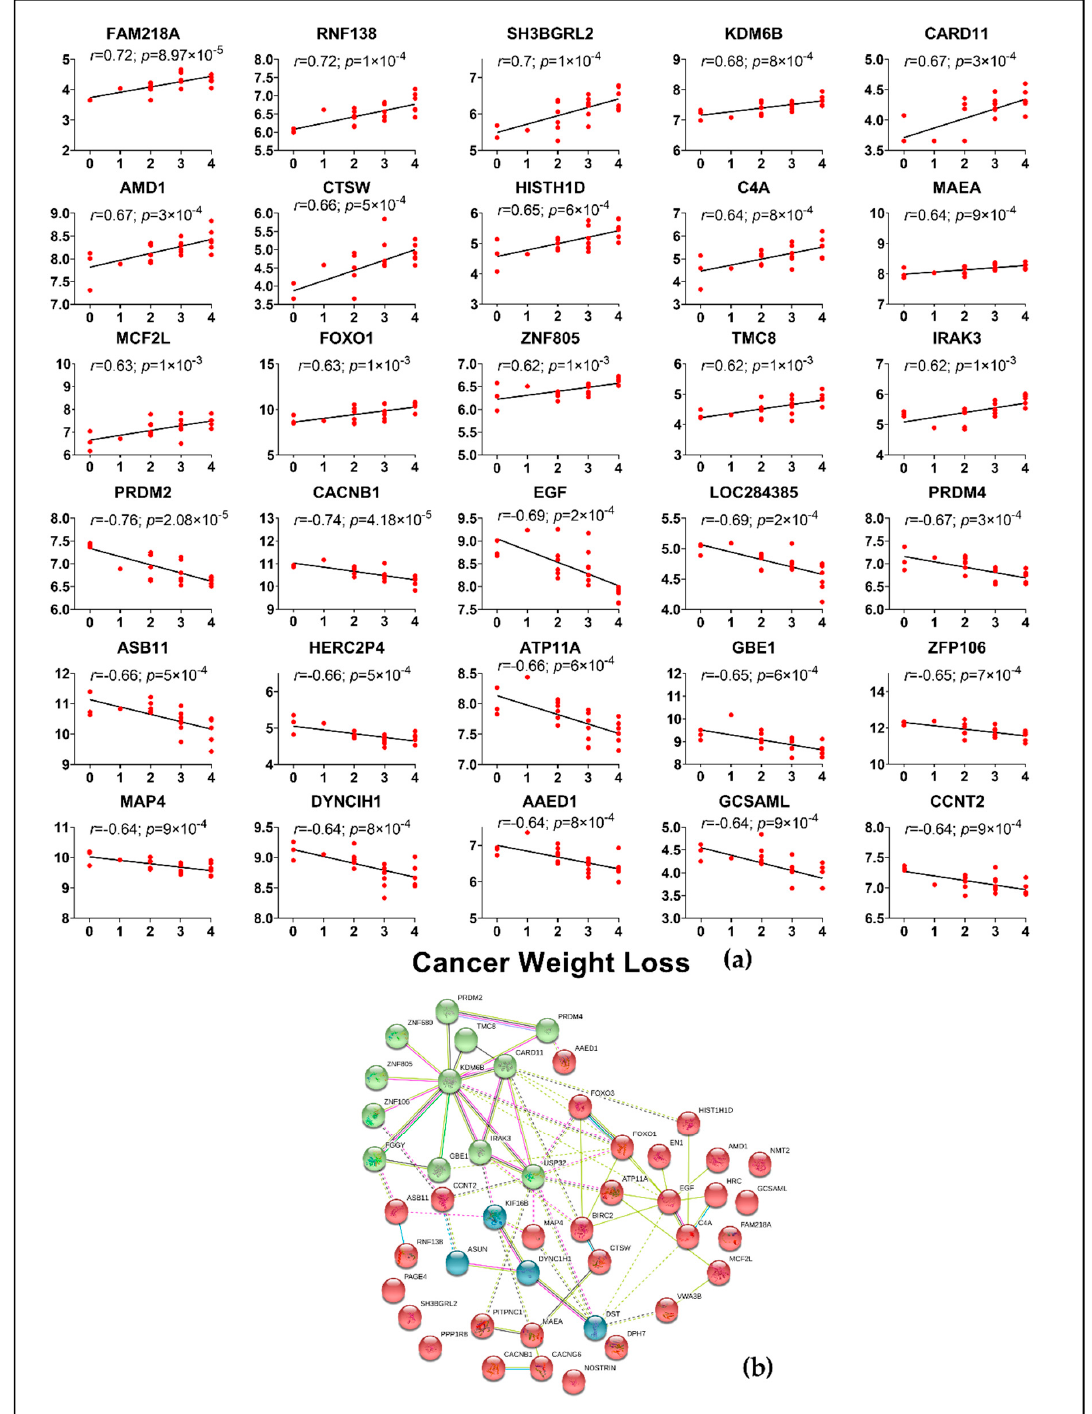
Figure 7. Top 30 muscle genes correlated with CWLG and gene network. ( a ) All genes were correlated against CWLG with PDAC samples alone. Spearman’s rank correlation was performed and only genes with r > 0.5 and p < 0.05 were considered. 340 genes correlated with CWLG; ( b ) the network was generated using the STRING database for the top 50 correlated genes with CWLG. Orphan networks were removed.